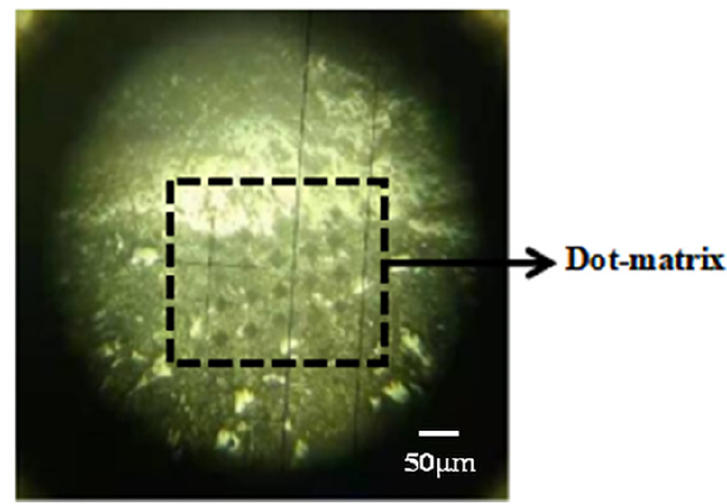
Figure 5. The actual picture after using the micro-hardness tester. As the old mortar attached by RCA was gray and the RC mixture was white cement, the sample can clearly distinguish the interface between old aggregate and old mortar (OA-OM-ITZ), the interface between old aggregate and new mortar (OA-NM-ITZ), and the interface between old mortar-new mortar (OM-NM-ITZ). Using a Tipscope Microscopic camera as shown in Figure 6, first, a 10 × 10 × 10 mm 3 concrete sample was cut with a metallographic concrete cutting machine to ensure that the side of the sample contained three kinds of ITZ. Then, all the other sides were sealed with paraffin wax except the observation surface. Finally, the sample was sprayed with gold and vacuumed for SEM (Hitachi, S-3400N) test.